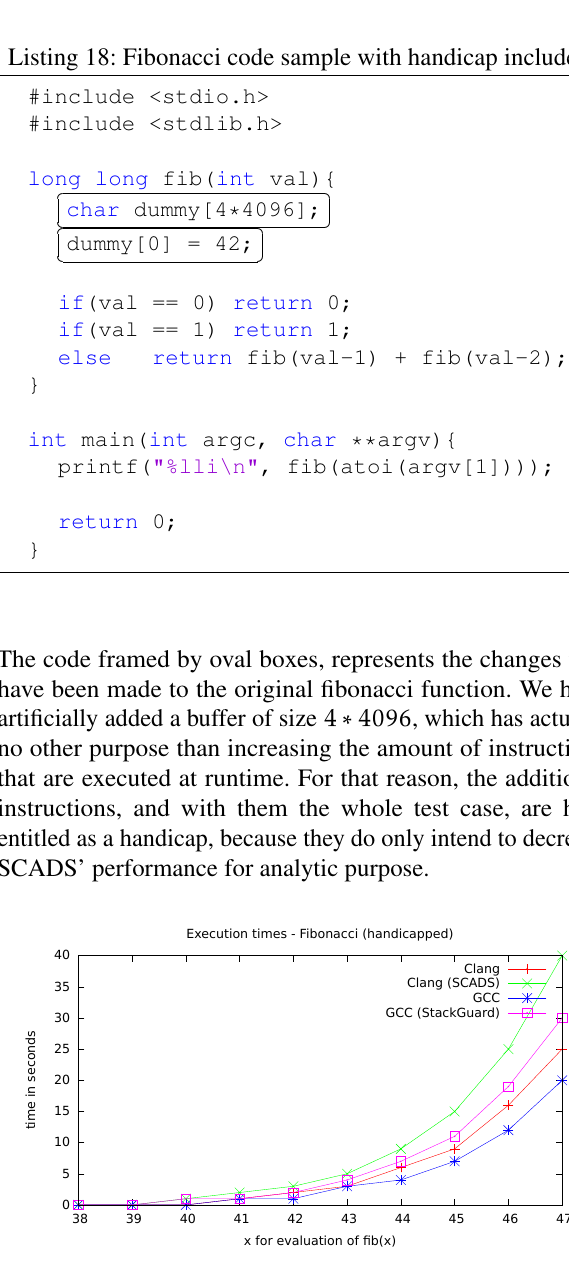
Figure 14. Execution times of the program defined by listing